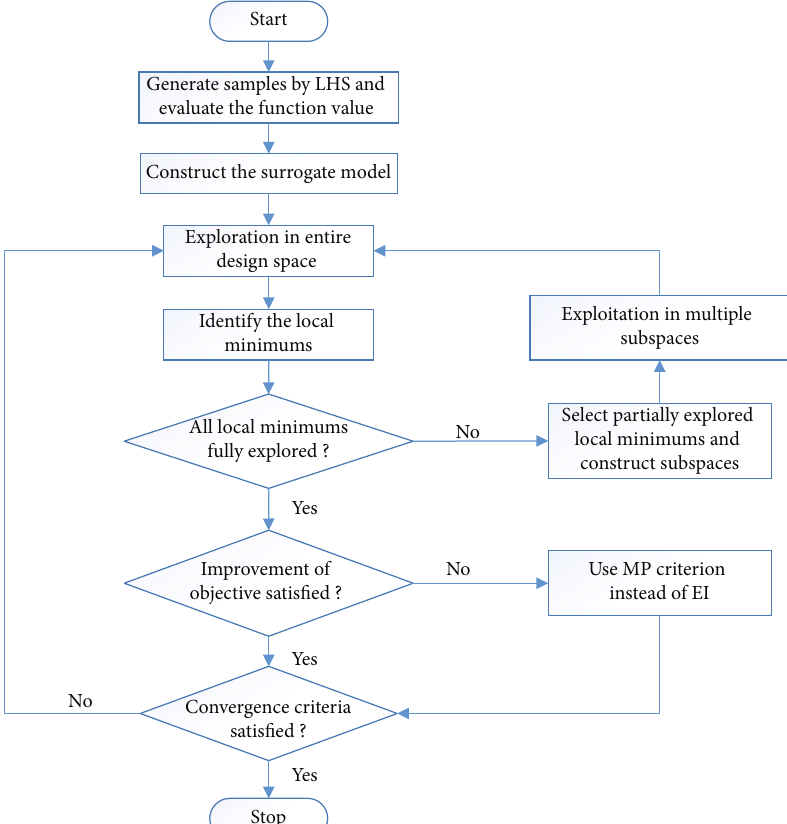
Figure 2: Flowchart of the KSE optimization